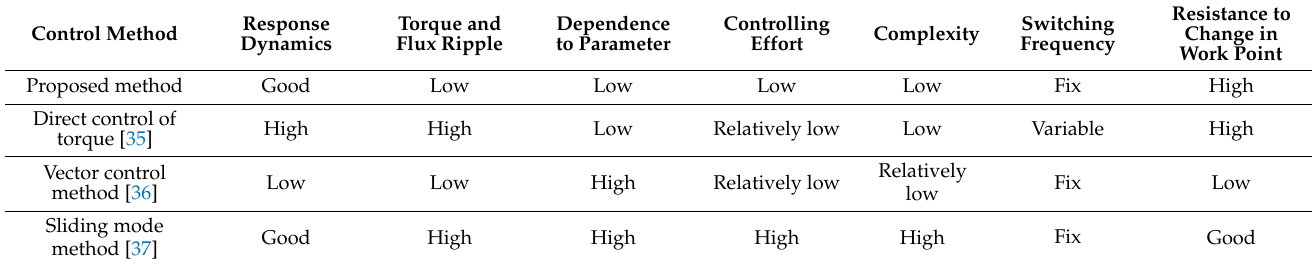
Table 1. Comparison of the qualitative performance of the proposed scheme to proposed control structures in